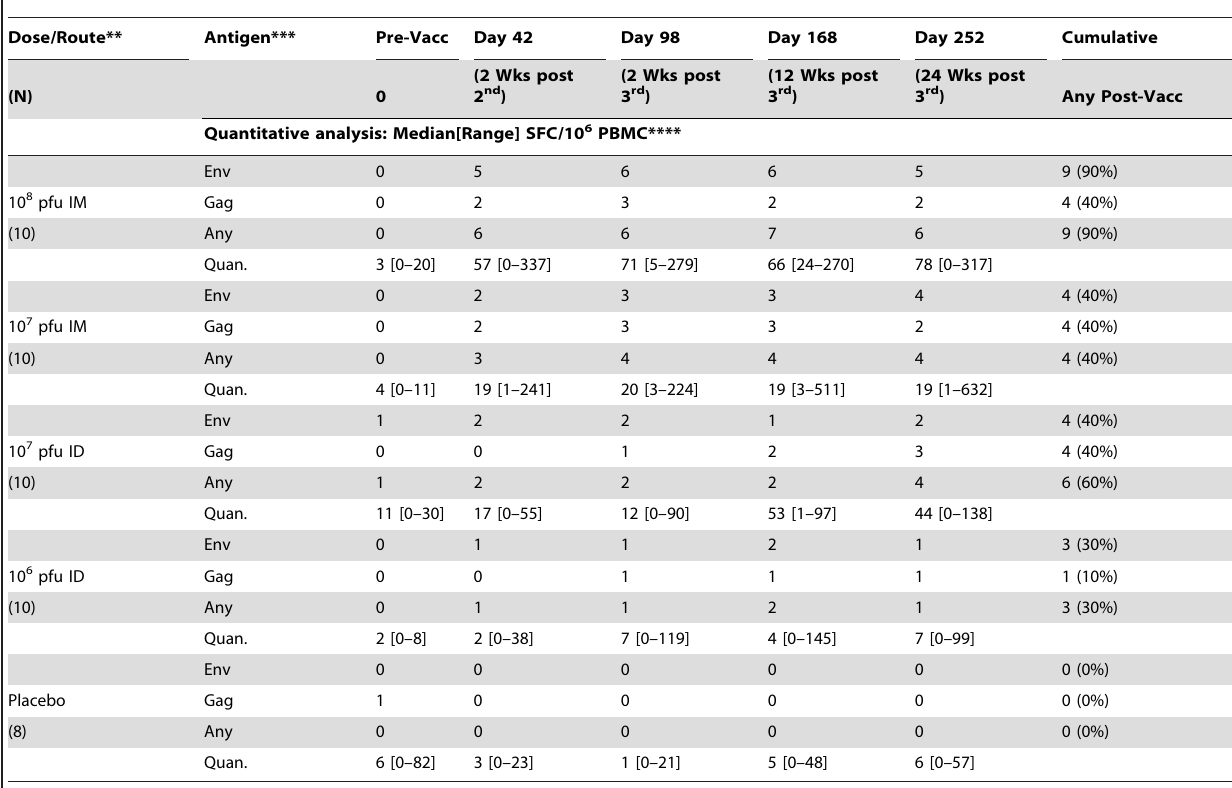
Table 3. Cross-sectional vaccine responsiveness as measured by the Interferon- c Elispot assay*.